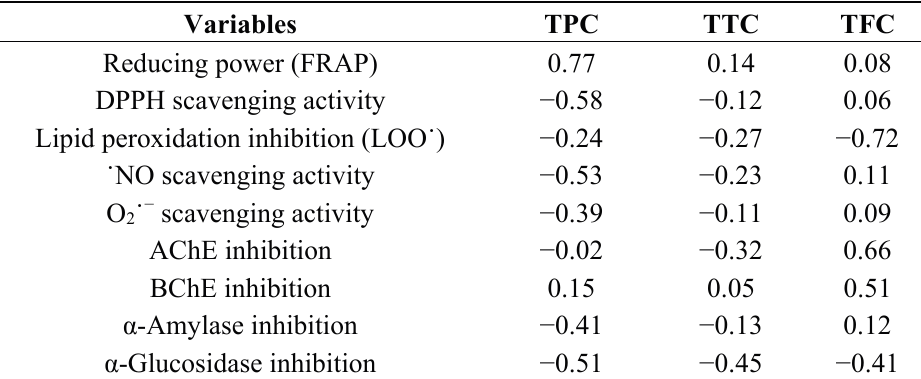
Table 3. Pearson correlation among total polyphenol content (TPC), total tannin content (TTC), total flavonoid content (TFC) and antioxidant activity (reducing power, 2,2-diphenyl-1-picryl hydrazyl (DPPH), ˙ NO, O 2 ˙ − scavenging activity and lipid peroxidation inhibition) and enzymatic inhibition (AChE, BChE, α -amylase and α -glucosidase enzymes